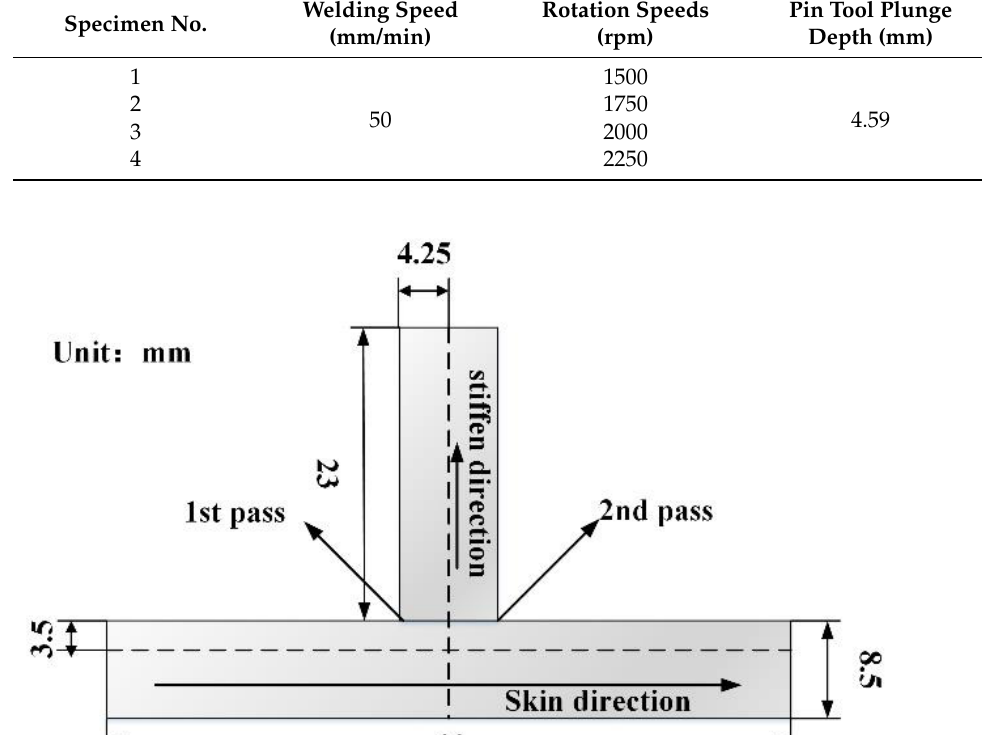
Figure 4. Tensile loading diagrams of SSFSW T-joint: ( a ) along the stringer direction and ( b ) along the skin direction, and ( c ) specimen dimensions. 3. Results and Discussion 3.1. Distribution Characteristics of the Temperature Field in SSFSW T-joints Figure 5 shows the comparison between the simulated thermal cycle curves and the measured results of the T-joint welded joint via SSFSW at a rotation speed of 2000 rpm and a welding speed of 50 mm/min as the first welds of the T-joint weld have a nearly identical temperature distribution pattern with the second welds. Therefore, only the tem- perature distribution field in the first welds was considered. The thermal cycle curves of the feature point featured a steep climb and slow decreasing variation trends. At the pre- heating phase, the temperature slowly rose from the room temperature; when the stirring pin moved closest to the feature point, the temperature at the feature point increased dras- tically; the welding entered into the stable phase at approximately 135 s, and meanwhile, both the front side and the rear side reached the peak temperature. At the stable welding phase, the material′s peak temperature to be welded was almost unchanged, and the tem- perature began to drop slowly as the stirring pin moved far away from the feature point. At the beginning of the welding process, the heat produced during high-speed fric- tion between the stirring pin and the material to be welded can be rapidly transferred on the surface of the material to be welded. At the stable welding phase, the heat produced by the stirring pin was constantly transferred to the surface of the material to be welded. Afterward, under the stirring action, the material to be welded was gradually filled from the front side to the rear side, and the pressure dropped gradually with time; accordingly, the heat generation by the friction of the stirring pin on the material to be welded gradu- ally dropped, and simultaneously, the heat source began to move away from the feature point. Therefore, the temperature dropped slowly after 135 s. It can also be observed that the simulated peak temperatures on both the advancing side (AS) and the retreating side (RS) exceeded the measured data by approximately 5 °C, suggesting that the simulation